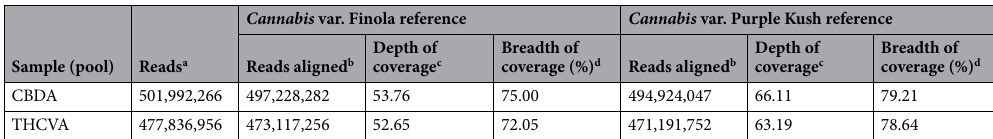
Table 1. Sequencing and alignment statistics. Haploid genome length for concatenated Cannabis sativa L. var. Finola reference [GenBank: ASM341772v2] is 1,010,967,789 bp; haploid genome length for the